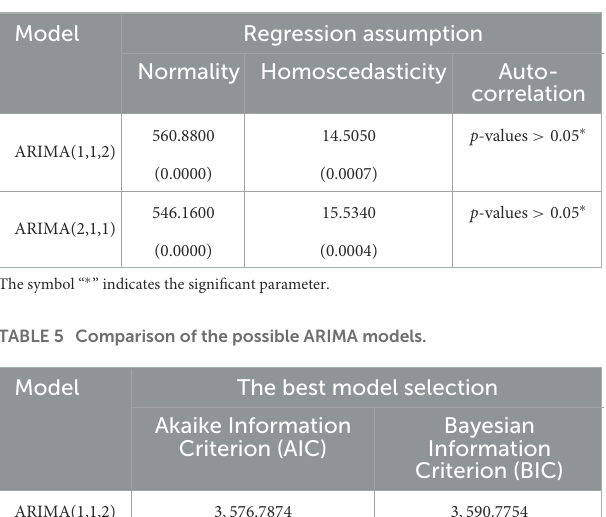
TABLE 4 Residual diagnosis checking for possible ARIMA model.